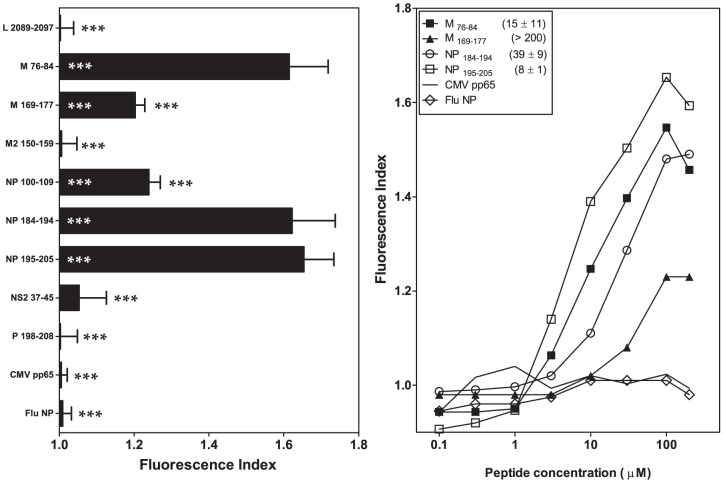
HLA-B*2701 stabilization with synthetic HRSV ligands.The stability of HLA-B*2701/peptide complexes on the cell surface of transfected RMA-S cells was measured through flow cytometry. The results shown in left and right panels are depicted as in Fig. 1A and 2B, respectively, showing the mean values obtained from three or four independent experiments.